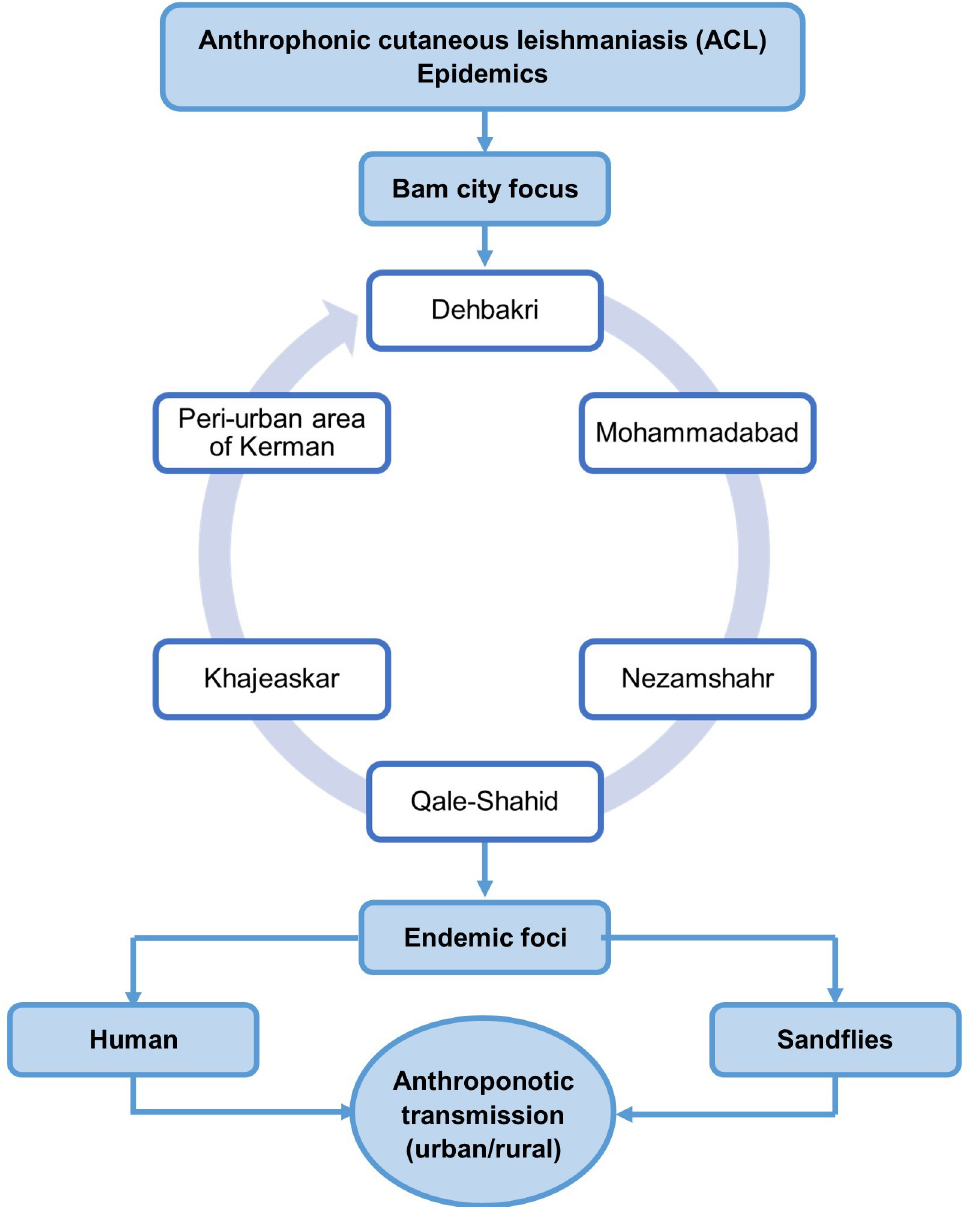
Fig 6. Illustrating the sequence of emerging foci in order of occurrence in Bam, southeastern Iran (1971–2020).